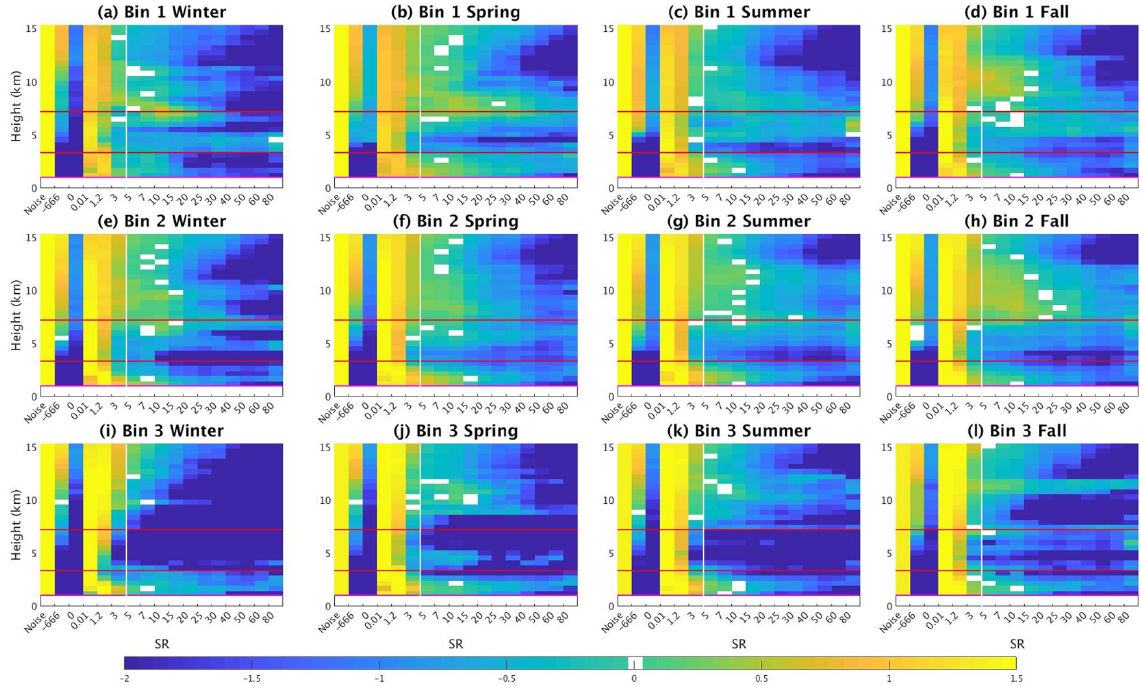
Figure 10. Lidar scattering ratio (SR (z) ) histogram obtained by cumulating all lidar observations during daytime for bin 1 (a–d) , bin 2 (e–h) , and bin 3 (i–l) for winter (first column), spring (second column), summer (third column), and fall (fourth column). The color bar is the logarithm of the percentage of occurrence (the sum of one level is equal to log 10 100%); lidar data showed in each subplot start above the instrument’s recovery altitude ( z = 1km); the red horizontal lines represent the limits of low-, mid-, and high-level clouds, and the white vertical line shows the threshold of cloud detection (SR (z) =